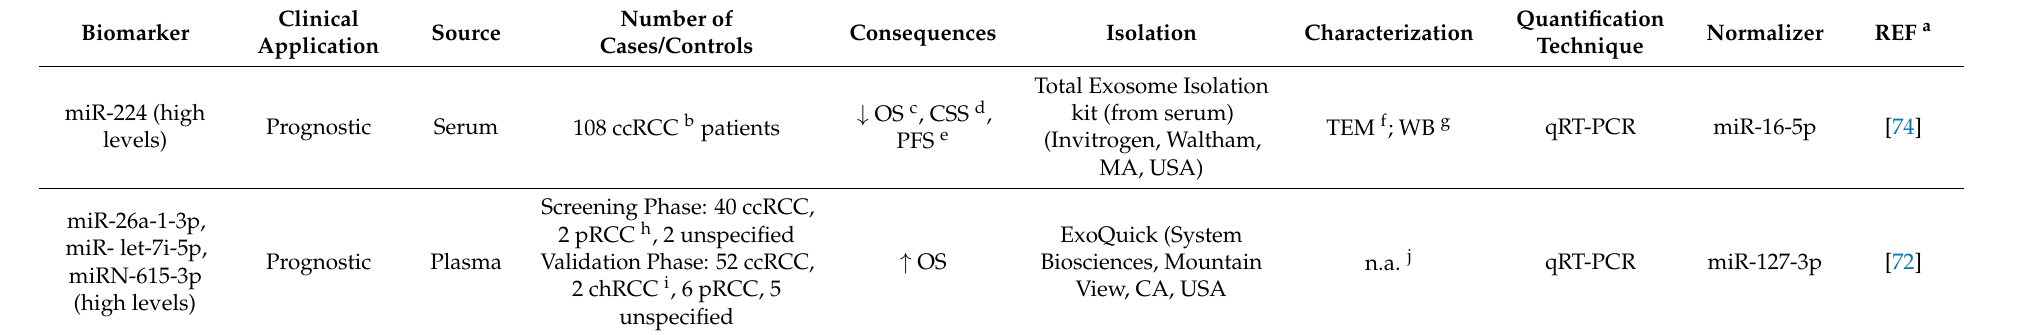
Table 4. Promising prognostic exosomal miRNA in renal cell carcinoma